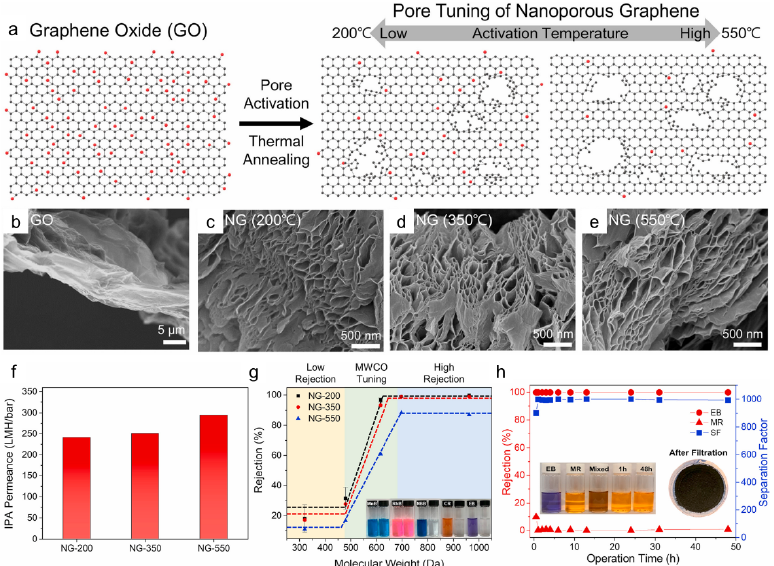
Figure 6. ( a ) Schematic illustration of the pore tuning of NG. ( b – e ) SEM images of the GO, NG-200, NG-350, and NG-550 particles, respectively. ( f ) Pure IPA permeance of the NG membranes. ( g ) IPA nanofiltration performance of NG membranes tested with dye molecules, including MnB, RhB, NBB, CR, and EB at 3 bar. ( h ) Long-term filtration performance of the NG-200 membrane under cross-flow filtration for 2 d [61]. Copyright 2021